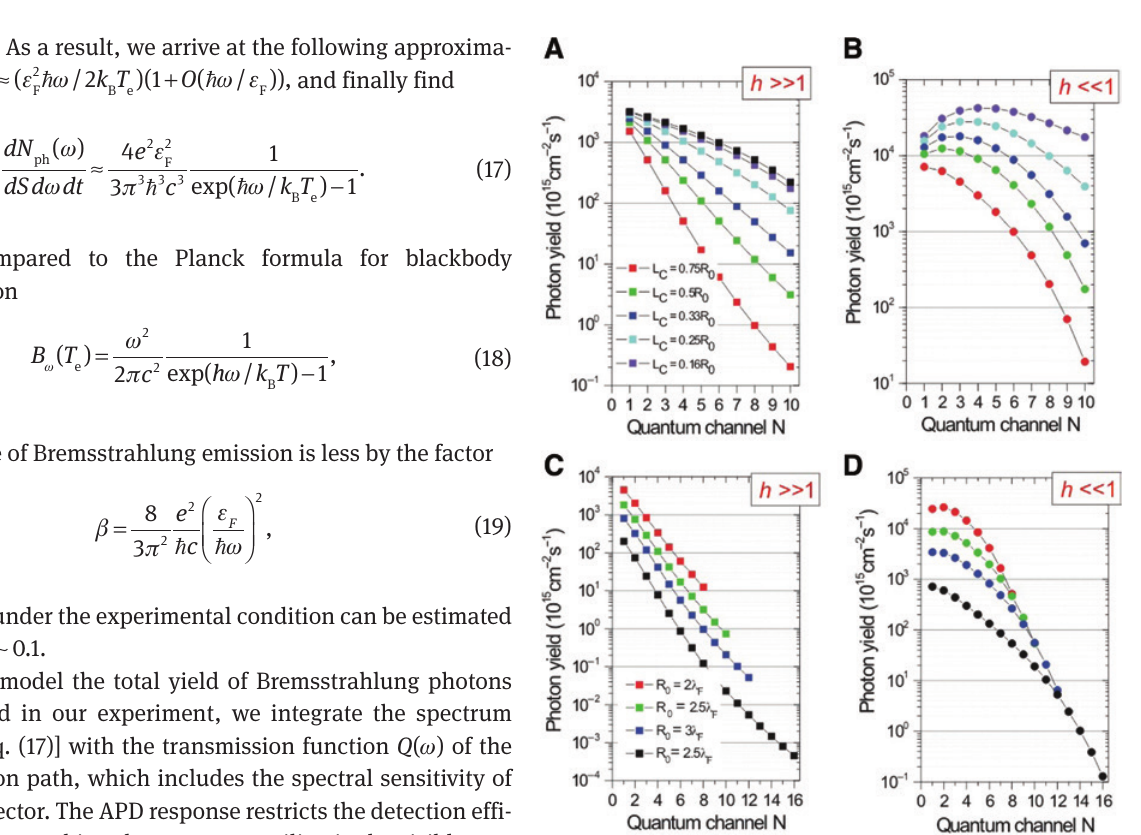
Figure 6: Thermal Bremsstrahlung radiation photon rates versus the number of open quantum channels in the contact. = 2.5 λ (A, B) Semilogarithmic plots at a fixed radius R . Squares 0 F represent data at large parameter h  1 (A), while circles correspond to h  1 (B). Data are plotted at different lengths of the = R = R = R interconnection region: L /6 (red), L /4 (green), L /3 c 0 c 0 c 0 = R = 3 R (blue), L /2 (cyan), and L /4 (violet). (C, D) Semilogarithmic c 0 c 0 = λ plots at fixed cylinder length L /2. Data are plotted at different c F = 2 λ = 2.5 λ radii of the cylinder interconnection region: R (red), R 0 F 0 F = 3 λ = 4 λ (green), R (blue), and R 0 F 0 F